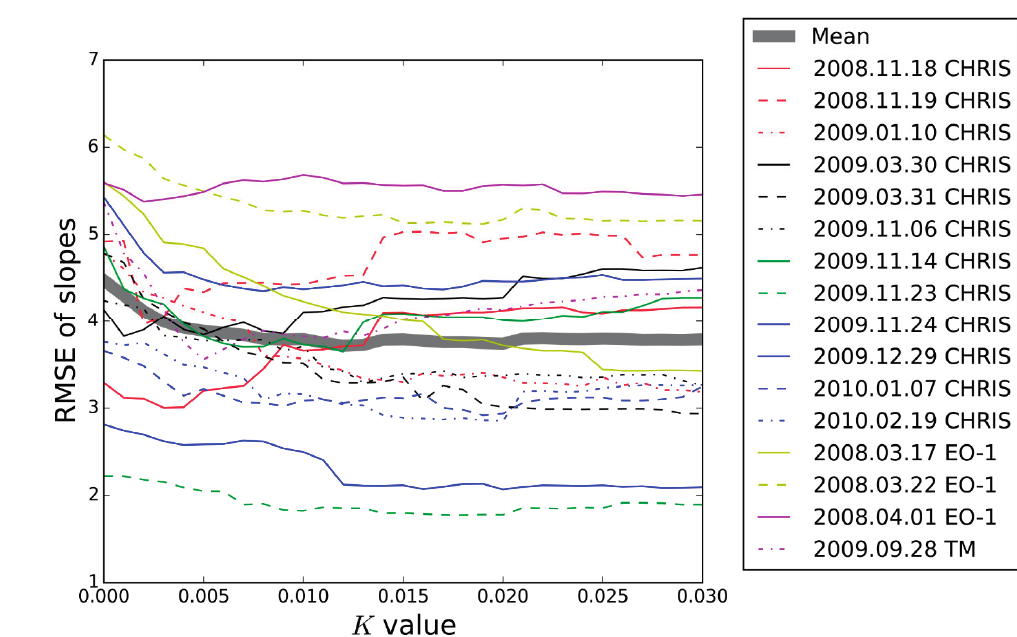
Figure 6. The RMSEs between the slopes of the downscaled snow covered subgrids and real snow covered subgrids for different K values.